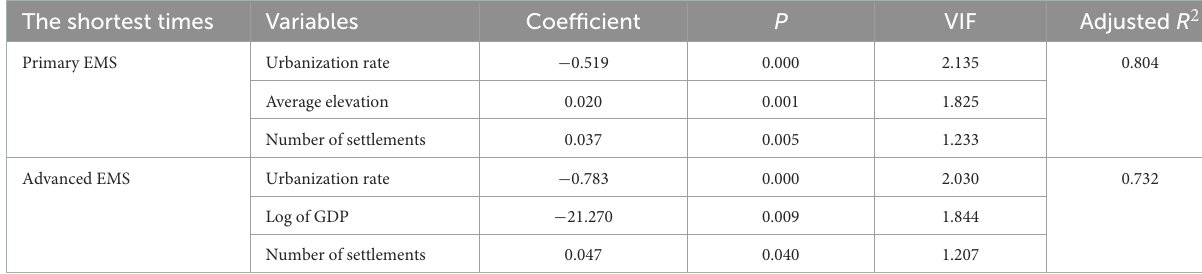
TABLE 8 Stepwise regression results of shortest travel times for primary and advanced emergency medical services (EMS). The shortest